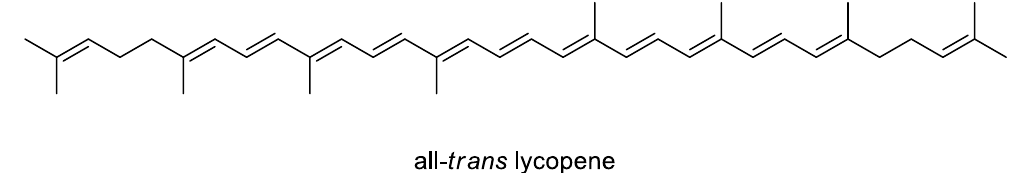
Figure 1. Structure of all- trans lycopene.